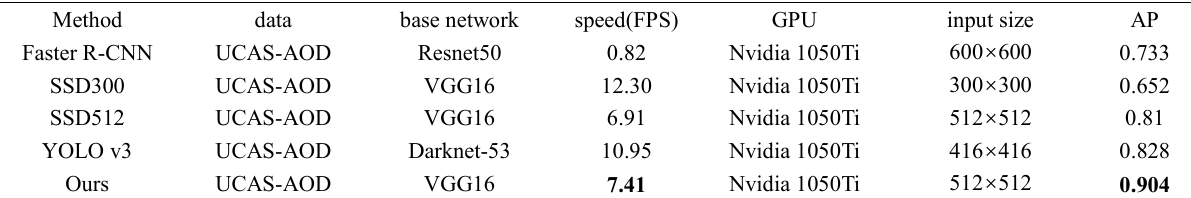
Table 2. UCAS-AOD test detection results. The speed of all models are tested on a single Nvidia 1050Ti GPU . The metric of speed is Frame per Second ( FPS